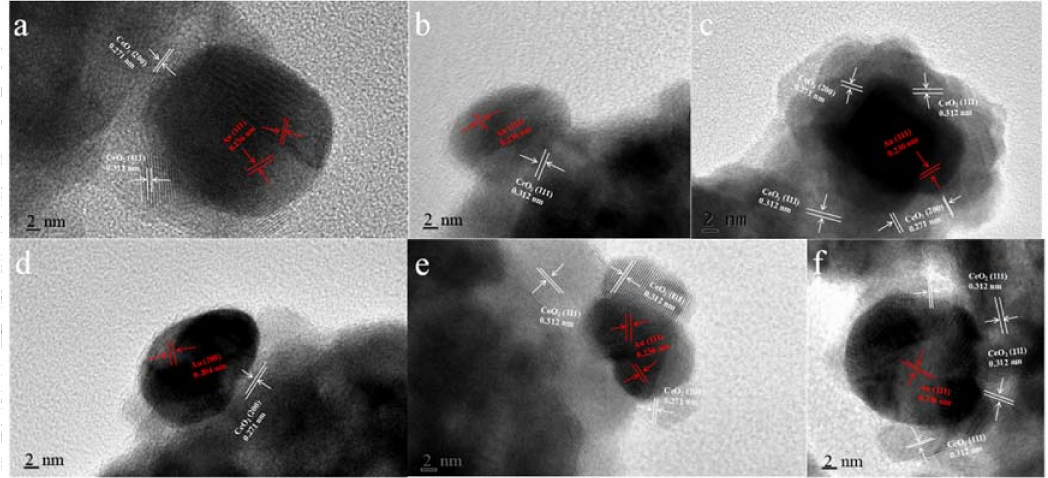
Figure 5. High-resolution transmission electron microscope (HRTEM) images of ( a ) AC-3, ( b ) AC-3-H, ( c ) AC-6-H, ( d ) AC-9-H, ( e ) AC-12-H and ( f )